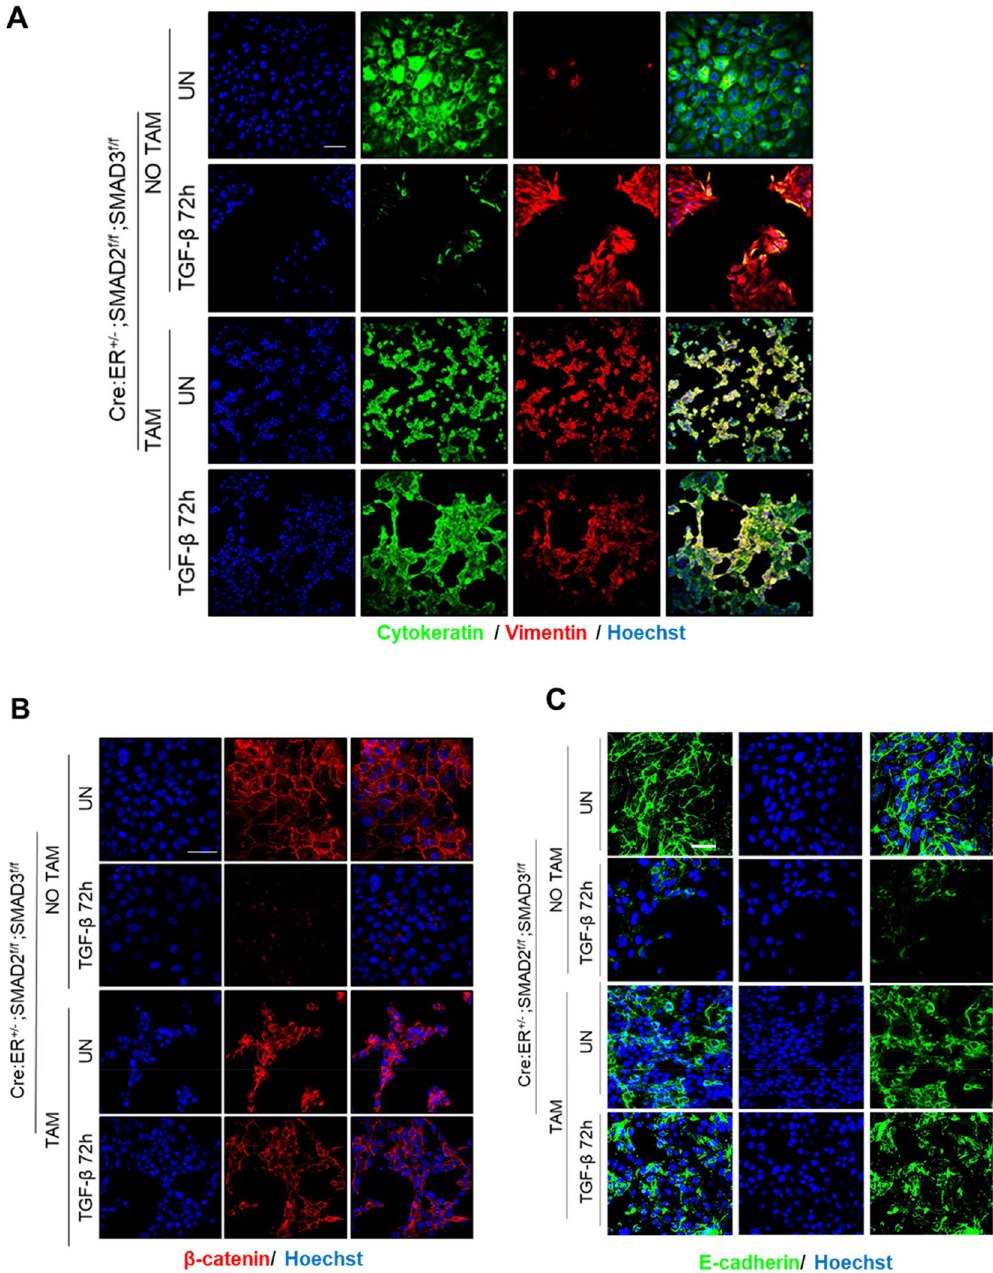
Figure 7. Representative confocal images of double cytokeratin and vimentin ( A ) β-catenin ( B ) or E-cadherin ( C ) immunofluorescence corresponding to 2D endometrial epithelial monolayers isolated from Cre:ER +/− ; SMAD2 f/f ; SMAD3 f/f . Cells were plated and treated with tamoxifen (TAM) to induce Cre:ER-mediated deletion of SMAD2 and SMAD3 alleles or left untreated (NO TAM) and then stimulated for 72 h with 20 ng/ml of TGF- β. Images were captured after 3 days of tamoxifen-induced deletion. Cells were counterstained with Hoechst to visualize nuclei. Scale bars: 25